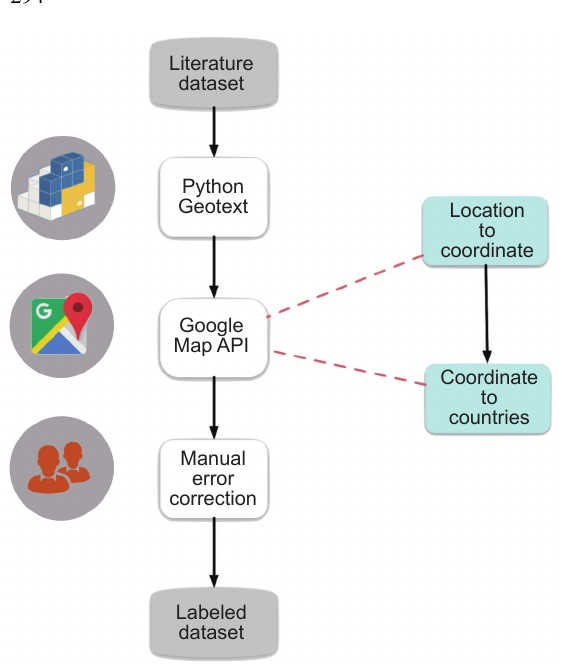
Fig. 5 Authors’ country information extraction.